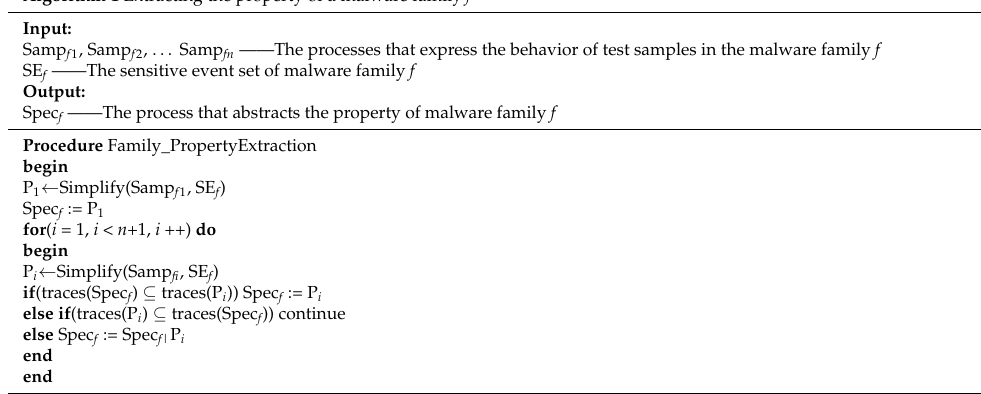
Algorithm 1 Extracting the property of a malware family